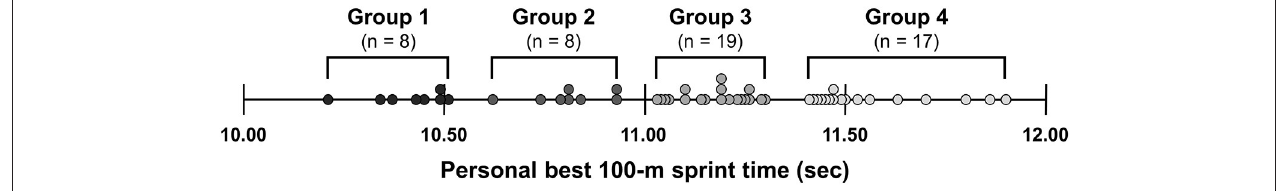
FIGURE 1 | Individual plots of the personal best 100-m sprint times in sprinters. A K -means cluster analysis was applied to divide the sprinters into four groups [Group 1: range, 10.21–10.51 (mean, 10.41 ± 0.10) s; Group 2: range, 10.61–10.93 (mean, 10.81 ± 0.10) s; Group 3: range, 11.03–11.30 (mean, 11.17 ± 0.09) s; and Group 4: range, 11.41–11.90 (mean, 11.56 ± 0.16) s] based on their personal best 100m sprint